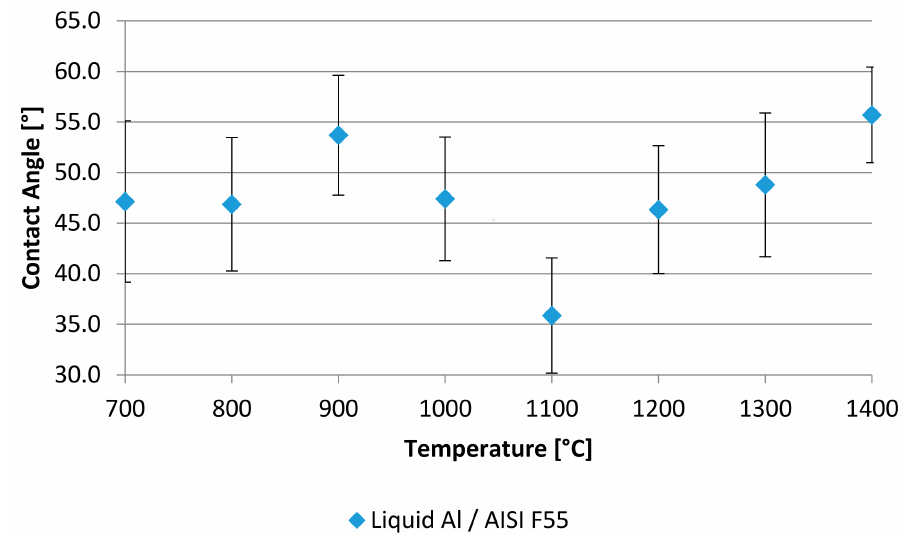
Figure 3. Sessile drop test describing the wettability by liquid aluminum of AISI F55 steel substrates, varying the